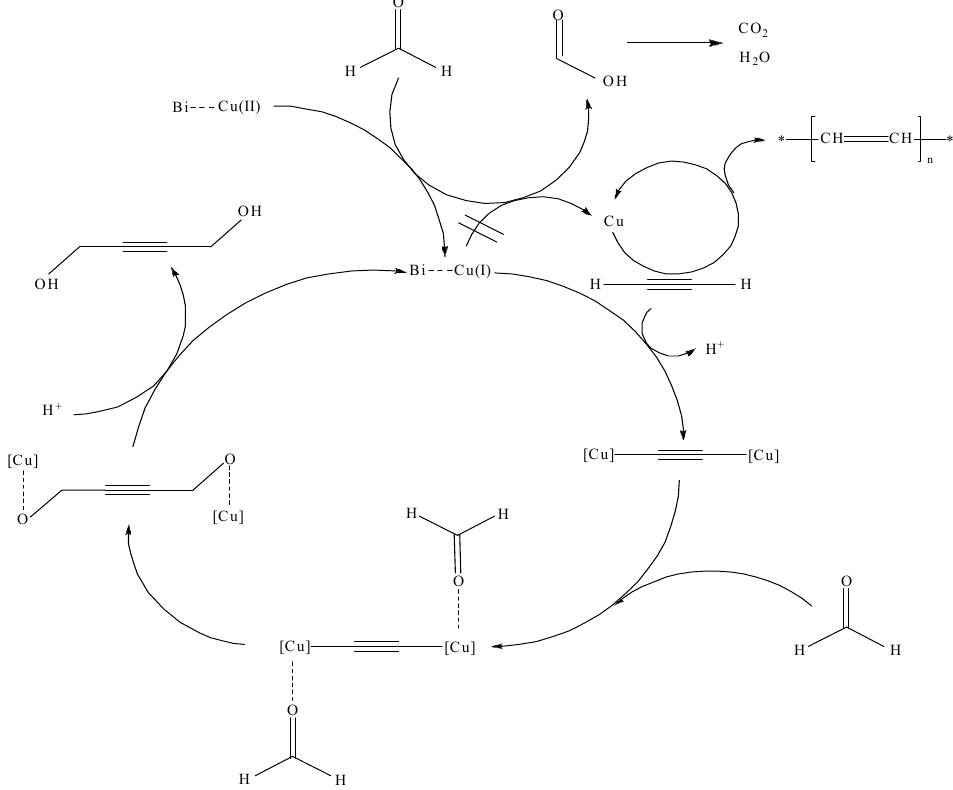
Figure 14. Plausible reaction mechanism for catalytic reactions involving CuO-Bi 2 O 3 .